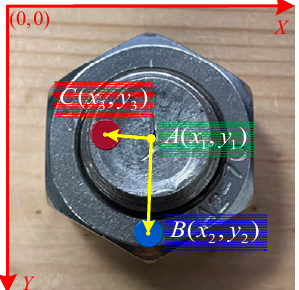
Figure 5. Center coordinates of the three classes. The angle with 𝐴 as the vertex is